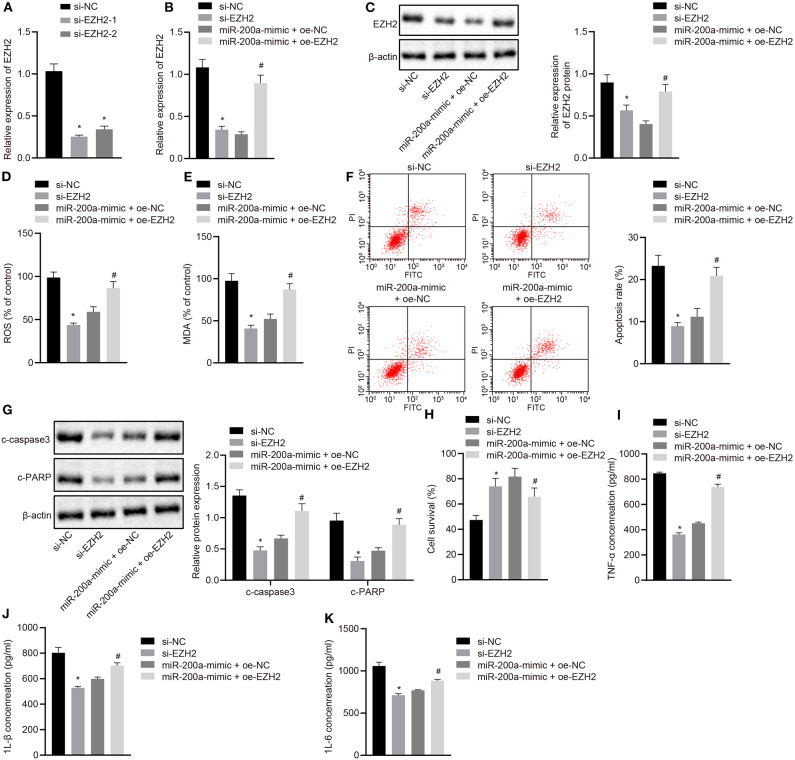
Silencing of EZH2 enables protective effects on HUVECs against ox-LDL-induced injury similar to miRNA-200a upregulation. HUVECs were treated with siRNA targeting EZH2-1 and EZH2-2 (with si-NC as control). (A) Interference efficiency of EZH2 in HUVECs measured by RT-qPCR. HUVECs were treated with siRNA targeting EZH2 (with si-NC as control) and exogenous miR-200a mimic and expression vectors containing EZH2 (with miR-200a mimic + oe-NC as control). (B) EZH2 expression in HUVECs determined using RT-qPCR, normalized to GAPDH. (C) EZH2 expression in HUVECs determined using Western blot analysis, normalized to β-actin. (D) ROS level in HUVECs measured with the ROS Assay Kit. (E) MDA level in HUVECs measured with the ROS Assay Kit. (F) Apoptosis of HUVECs detected by flow cytometry. (G) Protein levels of cleaved-caspase3 and cleaved-PARP in HUVECs determined by Western blot analysis, normalized to β-actin. (H) Cell viability of HUVECs detected by CCK-8 assay. (I–K) Concentration of TNF-α, IL-1β, and IL-6 in the culture supernatant of HUVECs measured by ELISA. *(relative to scramble siRNA-treated HUVECs) and #(relative to miR-200a-mimic + oe–NC) indicate p < 0.05 by one-way ANOVA/Tukey's post-hoc test.